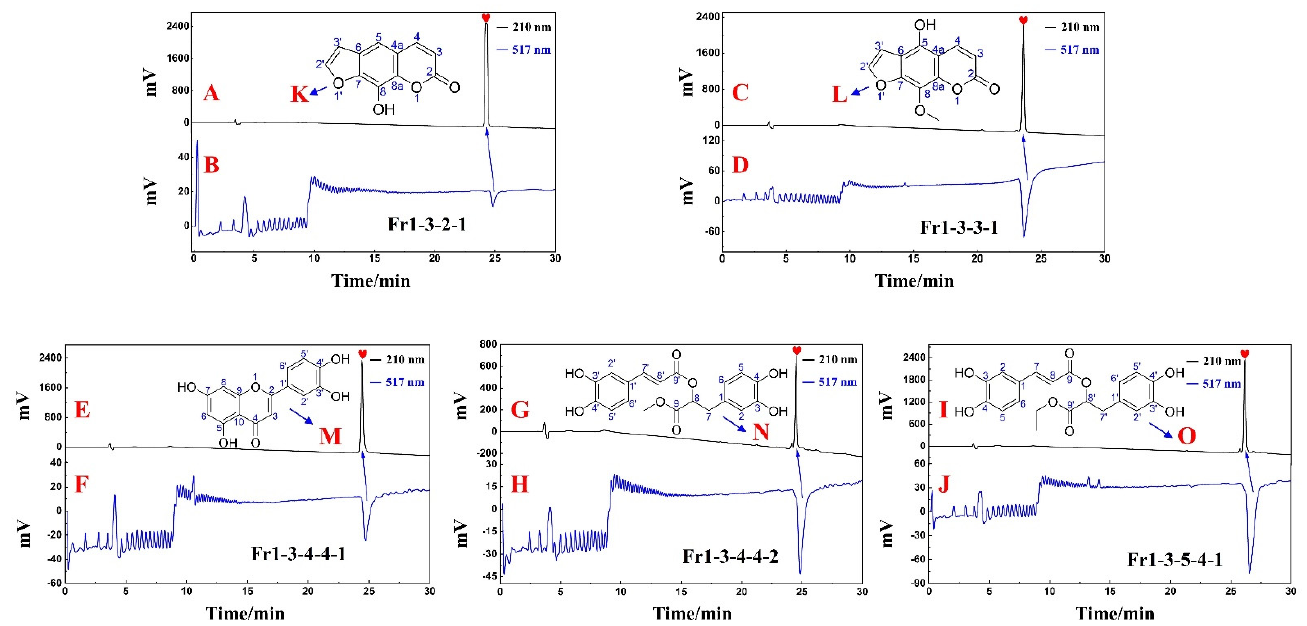
Figure 6. Purity and DPPH inhibitory activity verification chromatogram of the isolated Fr1-3-2-1 ( A , B ), Fr1-3-3-1 ( C , D ), Fr1-3-4-4-1 ( E , F ), Fr1-3-4-4-2 ( G , H ), and Fr1-3-5-4-1 ( I , J ). Chemical structures of Fr1-3-2-1 ( K ), Fr1-3-3-1 ( L ), Fr1-3-4-4-1 ( M ), Fr1-3-4-4-2 ( N ), and Fr1-3-5-4-1 ( O ) isolated from Fr1- 3 of D. heterophyllum .